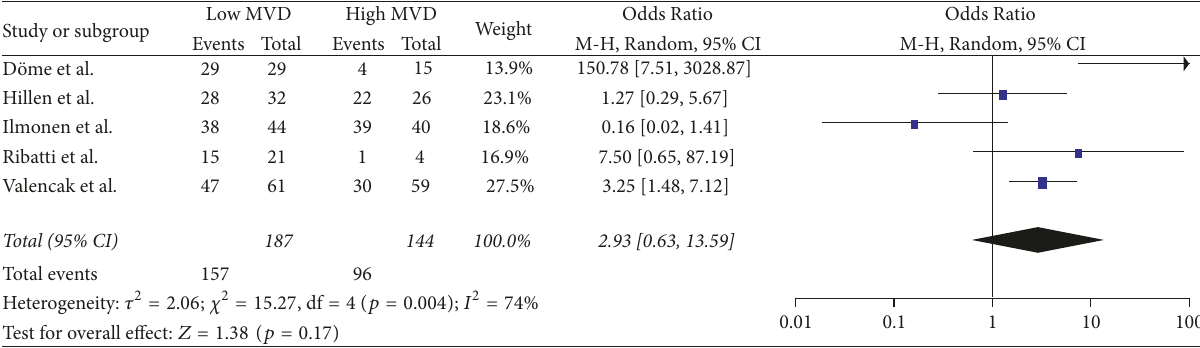
Figure 5: 36 months’ overall survival.